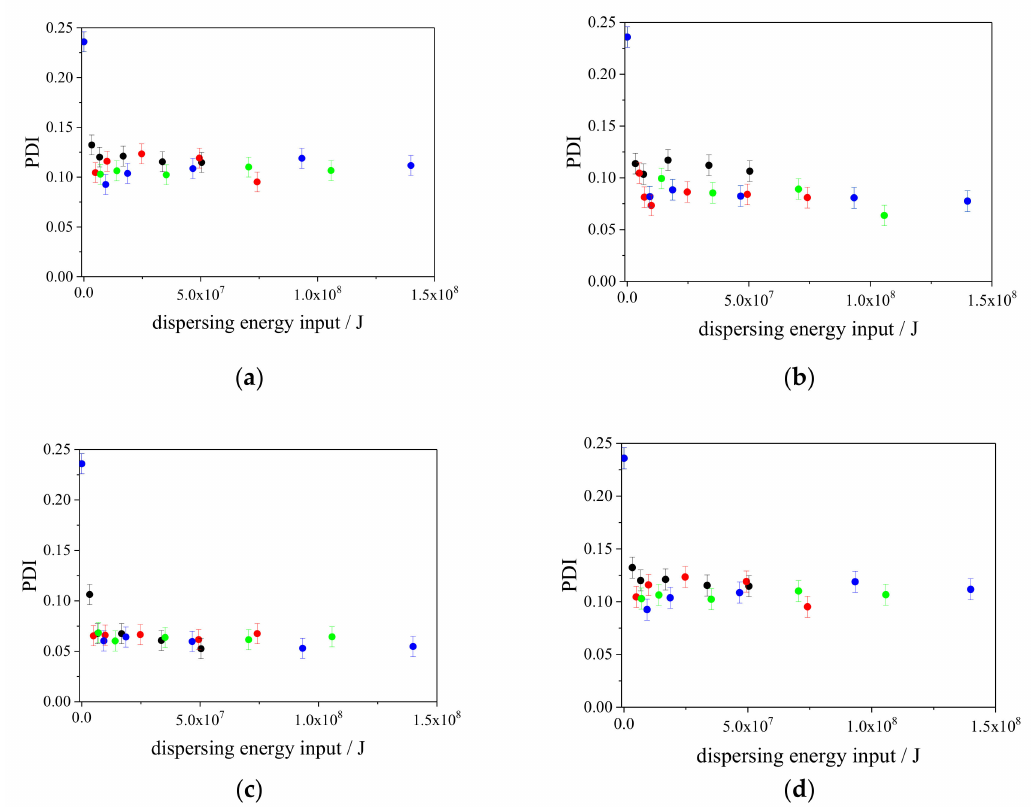
Figure 3. Plots of the PDIs of CaCO 3 particles in various aqueous media as functions of the dispersing energy input, as determined by DLS. The used surfactants are ( a ) Triton X-100, ( b ) SDS, ( c ) Softanol-70, and ( d ) CTAB. The plots are for different pressures in the narrow channel (80 MPa: black, 120 MPa: red, 180 MPa: green, and 240 MPa: blue). The uncertainties were calculated from the repeatability of the observed sizes, which were obtained from three separate